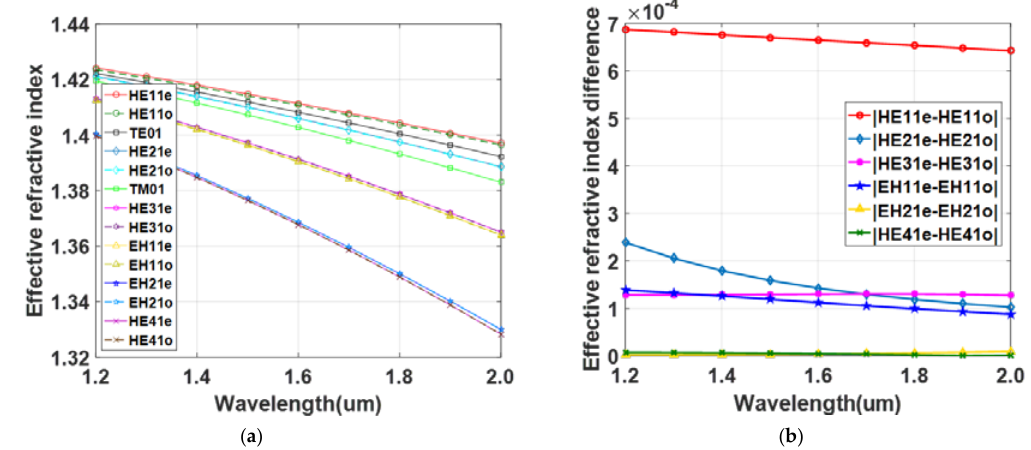
Figure 3 . ( a ) Effective refractive index as a function of stress for different modes; ( b ) effective index difference between even and odd modes as a function of stress.